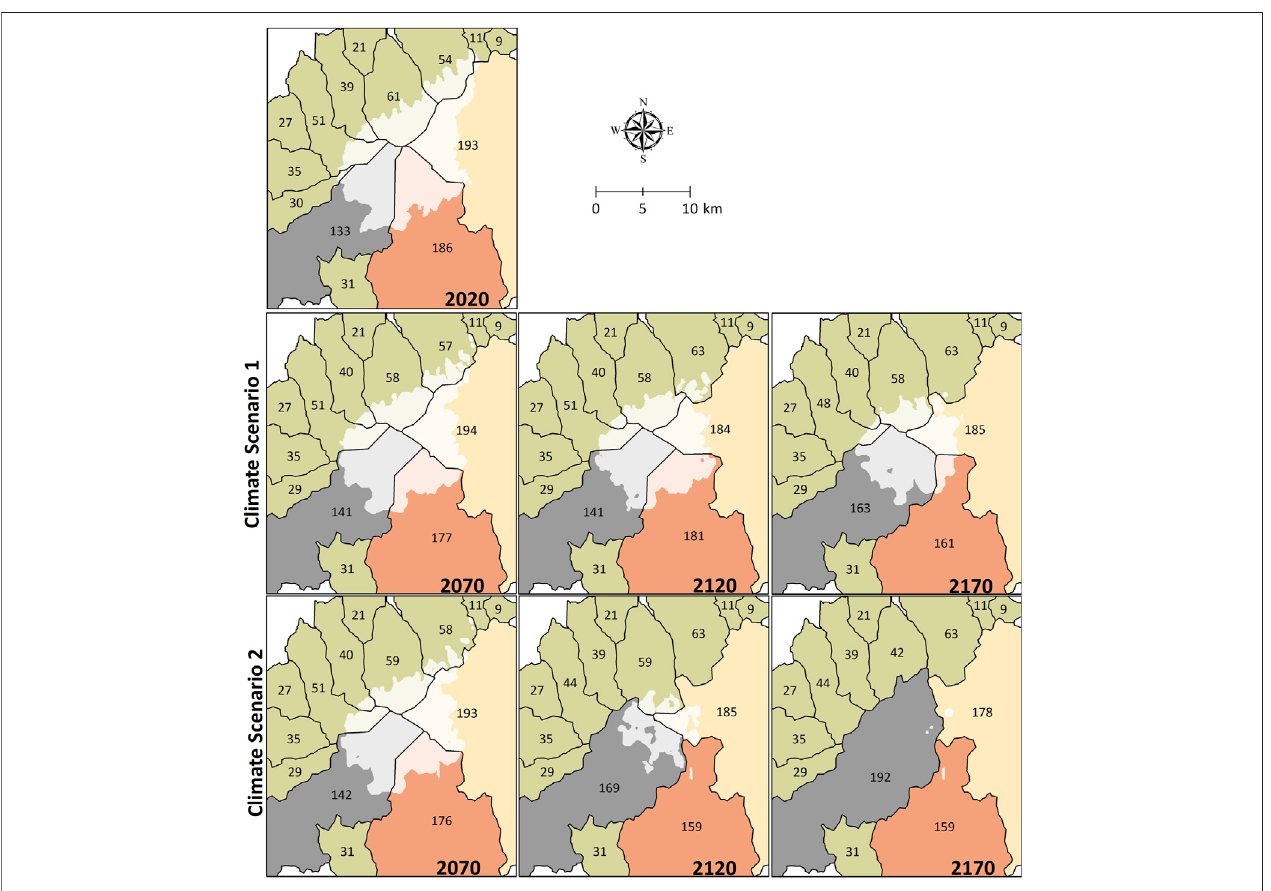
FIGURE 9 | Changes in different drainage catchments for three different years in both climate scenarios. The small numbers represent area (in km 2 ) and the white polygon is the modelled extent of the ice cap. The three largest drainage catchments have different colors to make it easier to visualize their change.